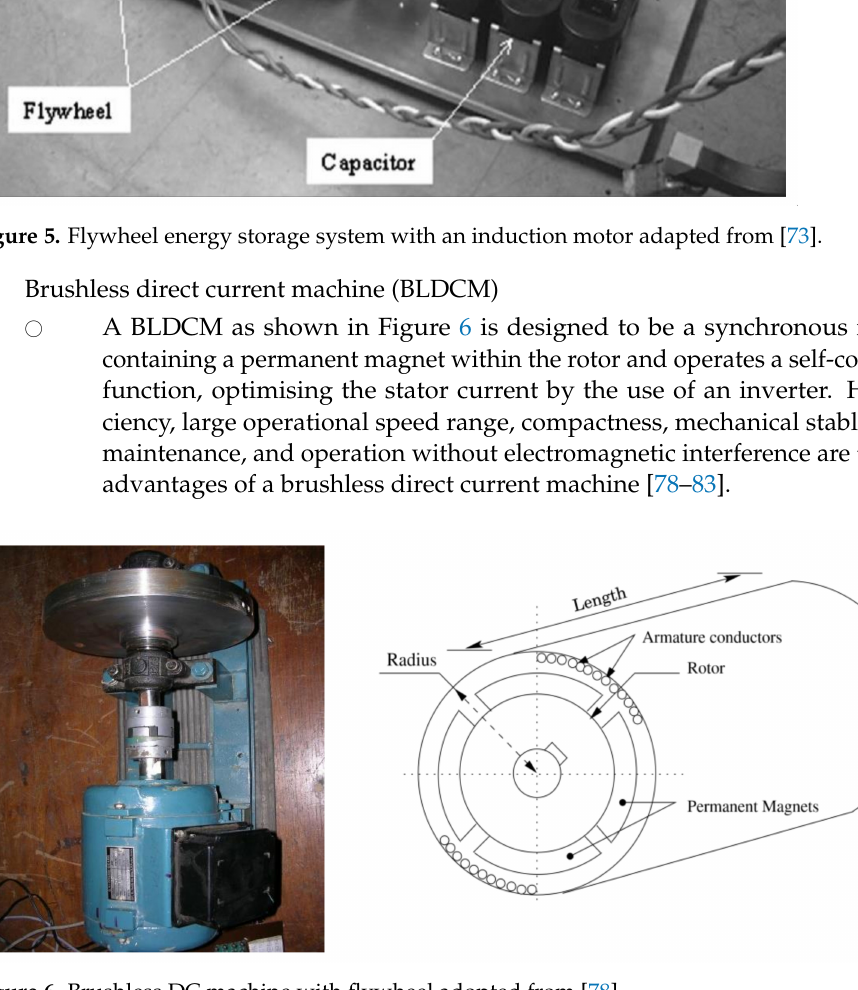
Figure 6. Brushless DC machine with flywheel adopted from